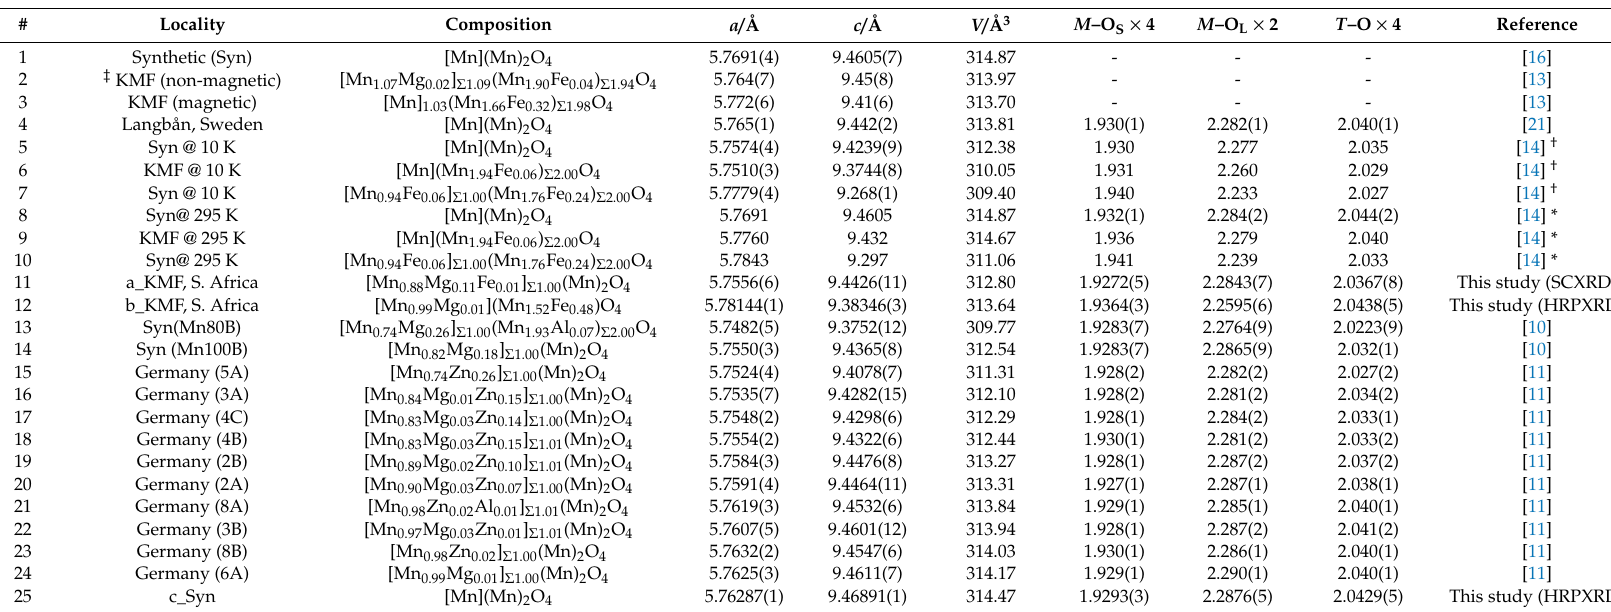
Table 1. Unit-cell parameters and bond distances for hausmannite, [4] [ T 2 + ] [6] ( M 3 + ) 2 O 4 , where T = tetrahedral site and M = octahedral